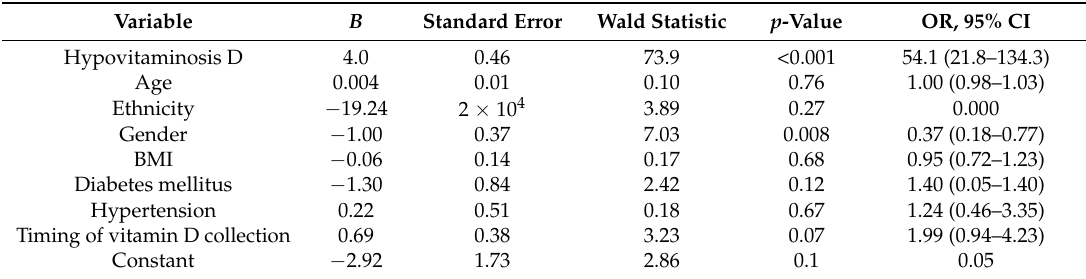
Table 4. Multivariable logistic regression analysis including confounders of age, ethnicity, gender, BMI, history of hypertension or diabetes mellitus, and timing of vitamin D